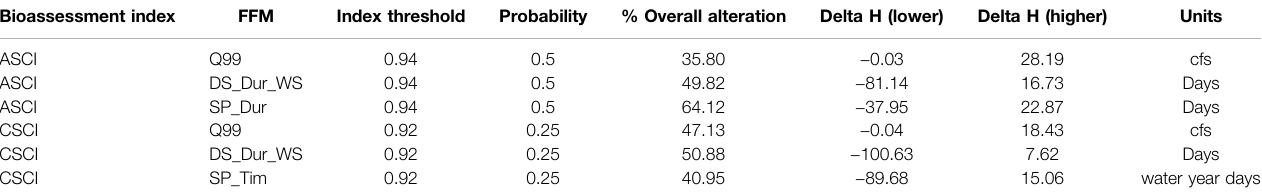
TABLE 3 | Final threshold combinations for each chosen metric, mean alteration over all sites and years and delta H limits for each FFM. Percentage of years altered per subbasin available in Supplementary Table S5 . Bioassessment index